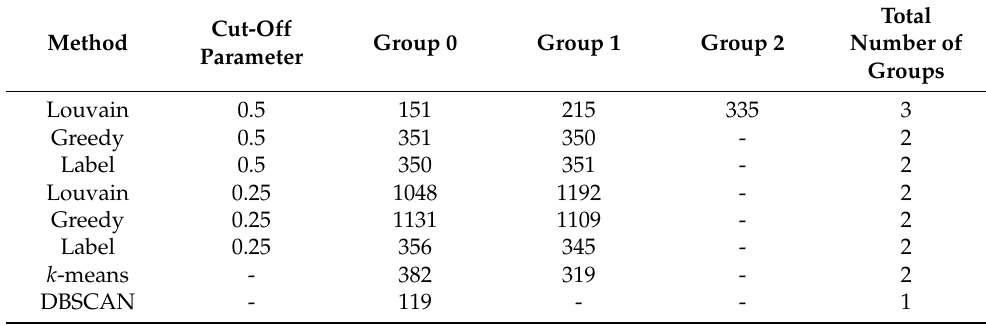
Table 11. Total number of groups and group sizes for each method (wholesale